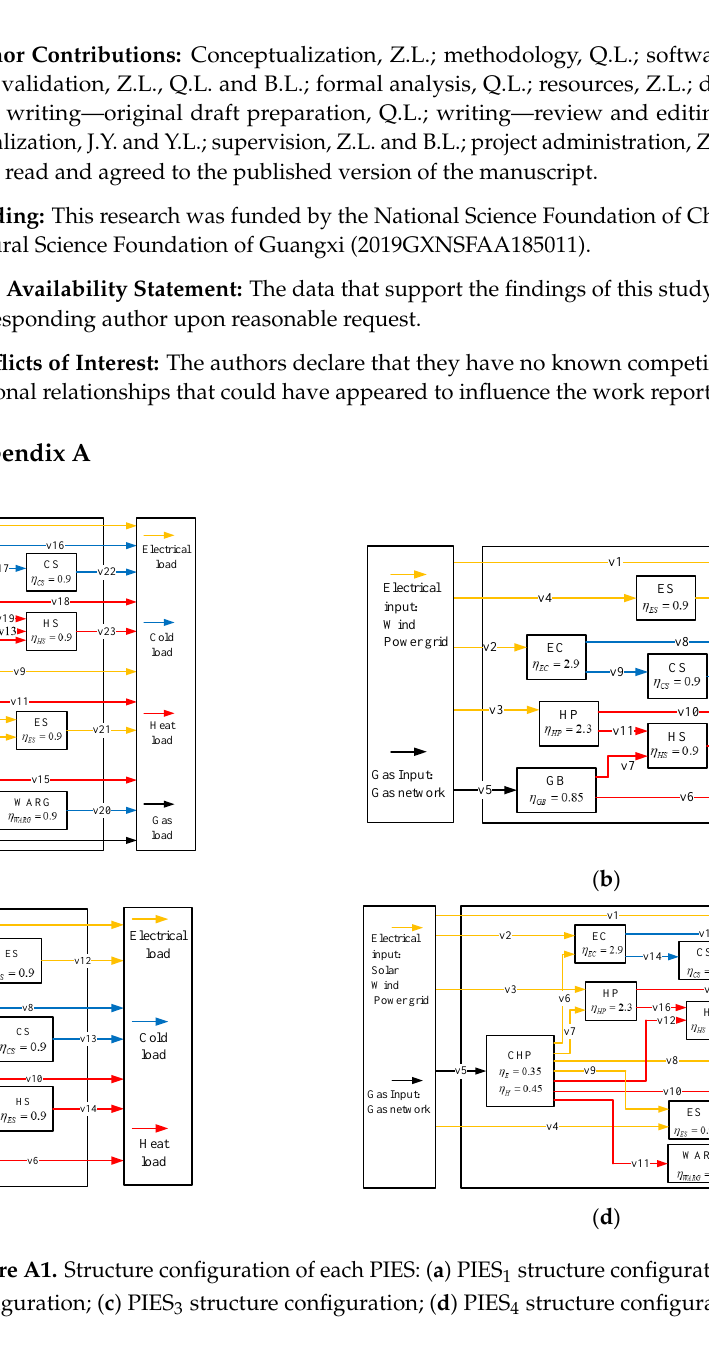
( d ) Figure A2. Renewable energy output and various load demand curves of each PIES: ( a ) PIES 1 renewable energy output and various load demand curves; ( b ) PIES 2 renewable energy output and various load demand curves; ( c ) PIES 3 renewable energy output and various load demand curves; ( d ) PIES 4 renewable energy output and various load demand curves.